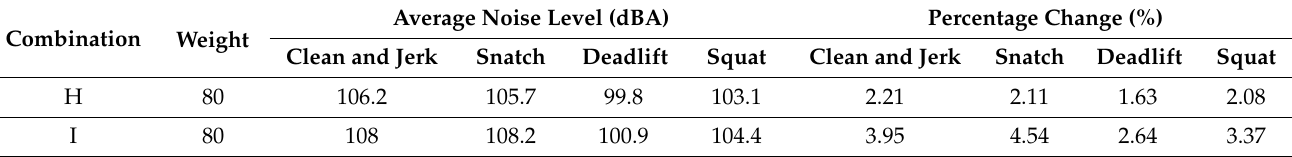
Table 4. Comparison of noise measurements.